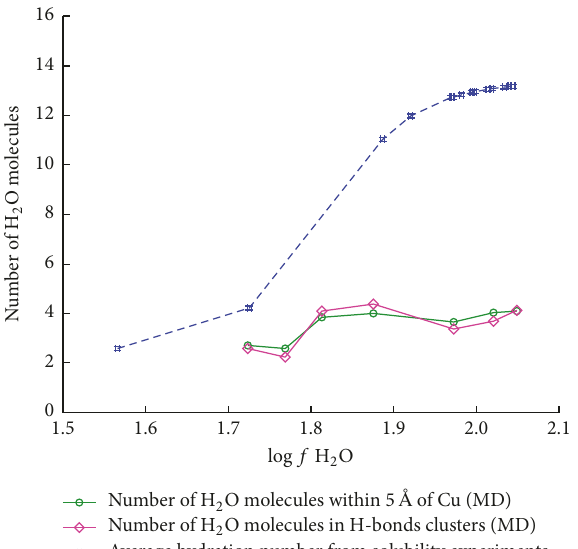
Figure 9: Average number of H 2 O molecules within 5 ˚A of CuCl 0 (green circles), average number of H 2 O in H-bonds clusters (pink diamonds), and average hydration numbers based on the solubility study (blue hatches) of Migdisov et al. [3]. Also shown is the hydration number calculated using the thermodynamic properties of hydrated CuCl ⋅𝑛 H 2 O 0 determined from solubility experiments by Migdisov et al. [3]. For each experimental solution, the average hydration number (Hy) was calculated using the equation Hy = (∑ 𝑛 (𝐶 ∗ 𝑖))/𝐶 𝐶 𝑖 total , where 𝑖 is the concentration of the hydrated 𝑖=1 CuCl species with 𝑖 water molecules, n is the total number of hydrated CuCl species, and 𝐶 total is the total